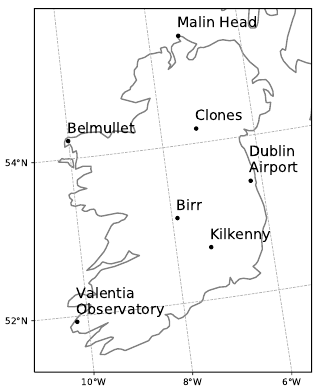
Figure 1. Irish weather observing stations used in this study.